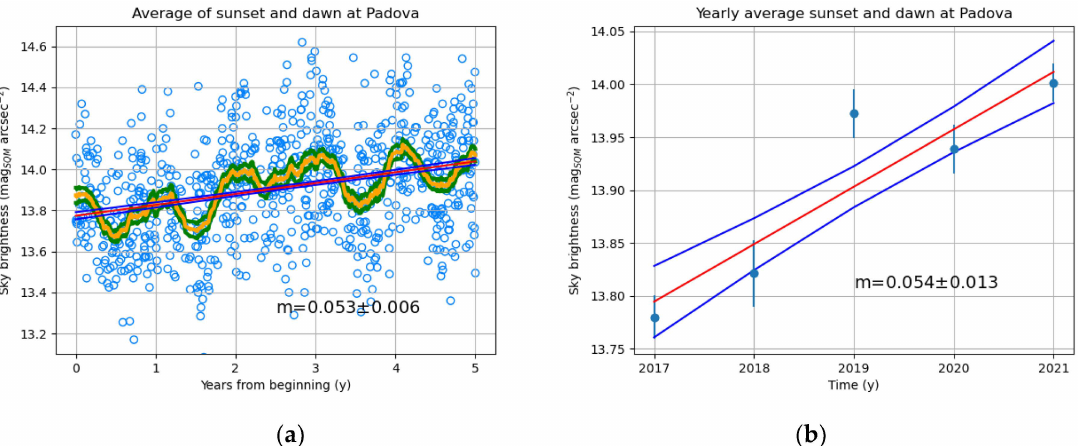
Figure 7. Trends of the sky brightness at zenith at Padova: average values at sunset and dawn ( a ) with their moving average (yellow curve) and aside the green curves accounting for one standard deviation ( a ) and the annual average values ( b ) when the Sun altitude is around − 6.5 ◦ , the red line is the linear fitting and the blue curves account for the uncertainty on the fitting parameters.